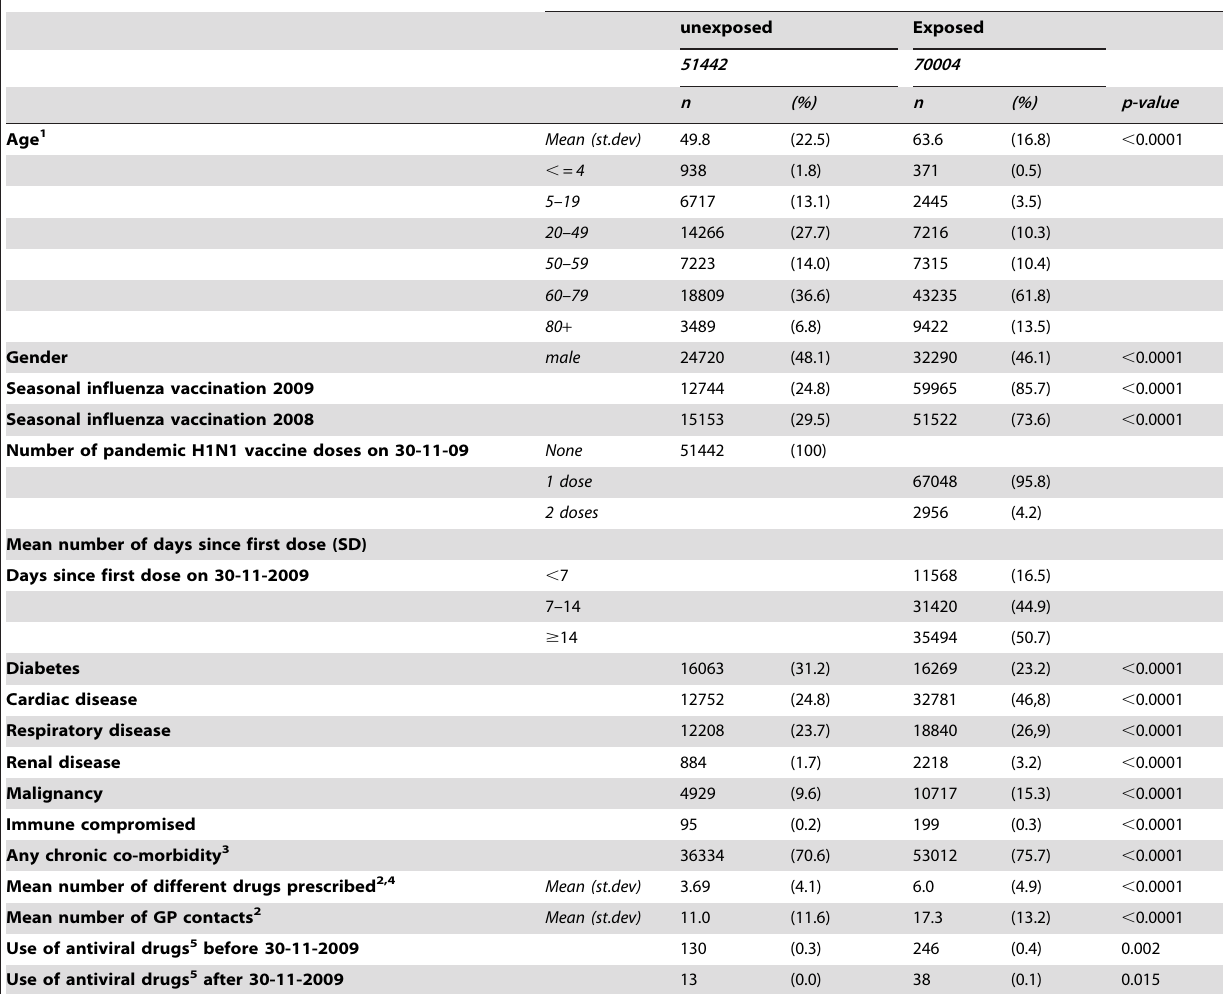
Table 1. Baseline characteristics